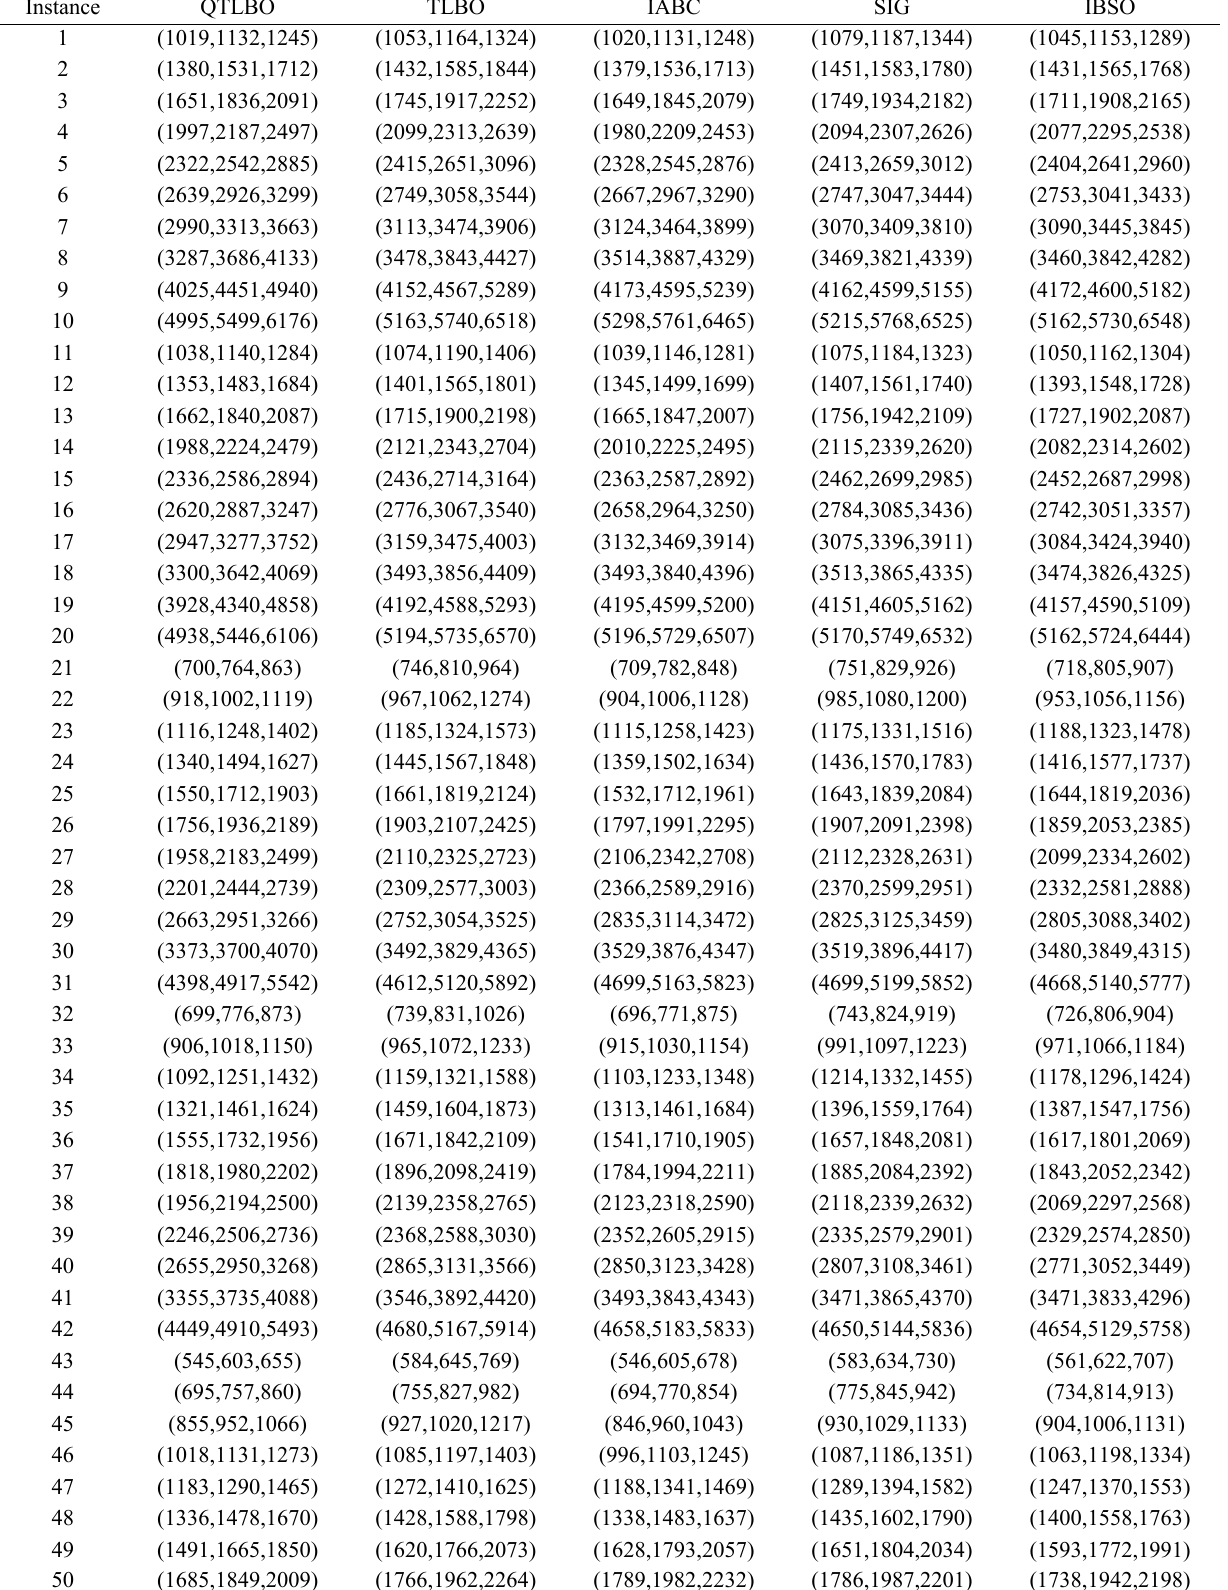
Min Table 7 Computational results of all algorithms on for instances